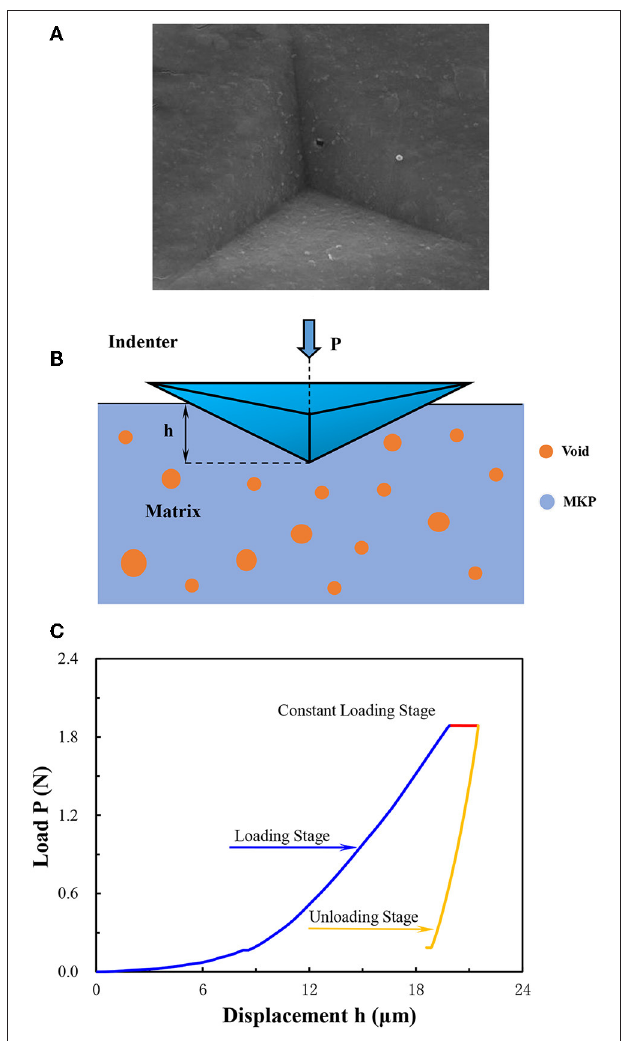
FIGURE 1 | (A) A typical SEM image of the nanoindentation; (B) The schematic diagram of nanoindentation; (C) The typical load-displacement curve of